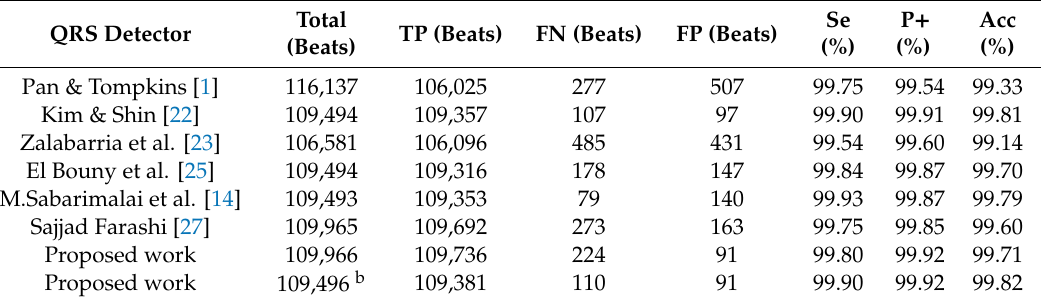
Table 6. R-peak detection performance comparison with other methods.